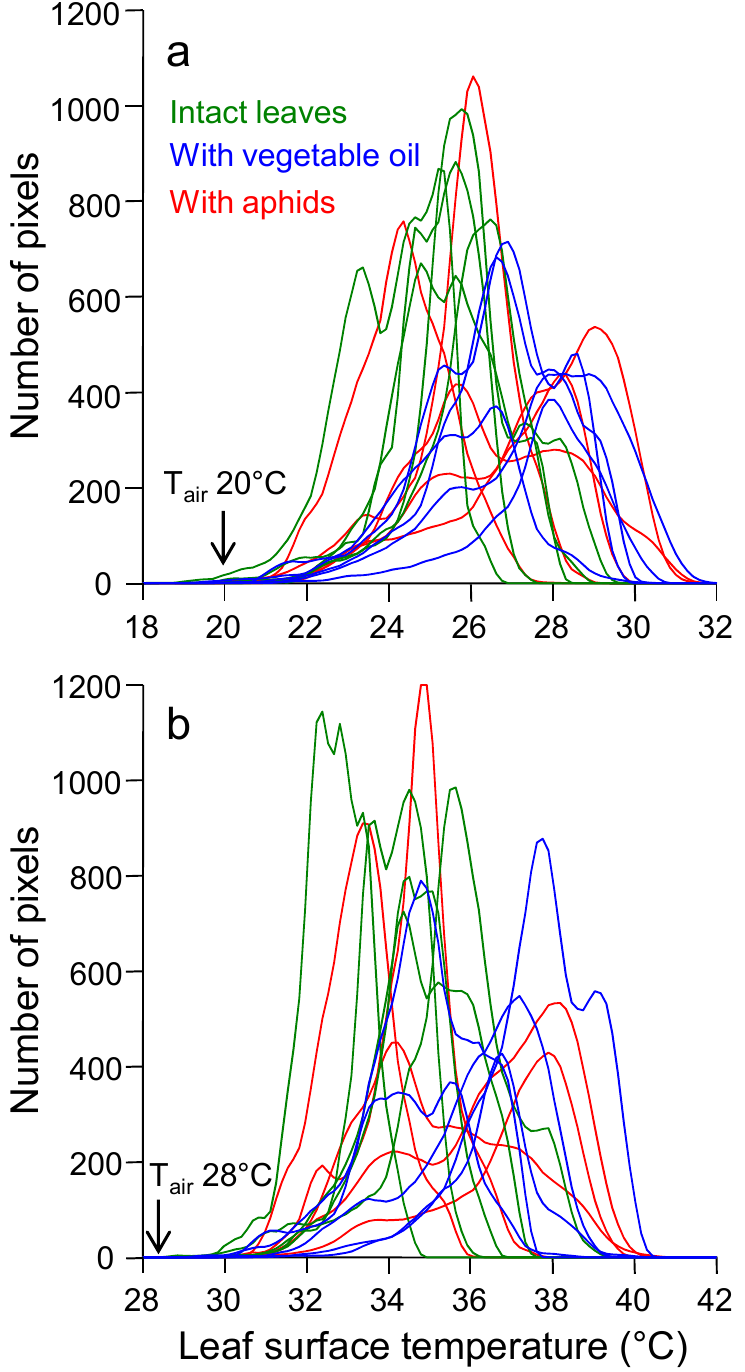
Figure A3. Leaf surface temperature distribution of each leaf in the three treatments at air temperature ( a ) 20 °C (at 11:00) and ( b ) 28 °C (at 13:30): intact leaves (green), leaves covered with vegetable oil to inhibit transpiration (blue) and leaves infested with green apple aphids (red). Each curve is the kernel distribution for a single leaf and it shows the number of pixels per temperature bin (every 0.1 °C). Kernel distributions allowed us to visualize the asymmetry and sometimes the bimodality of the distributions. The arrows on the X -axis indicate the air temperature values.